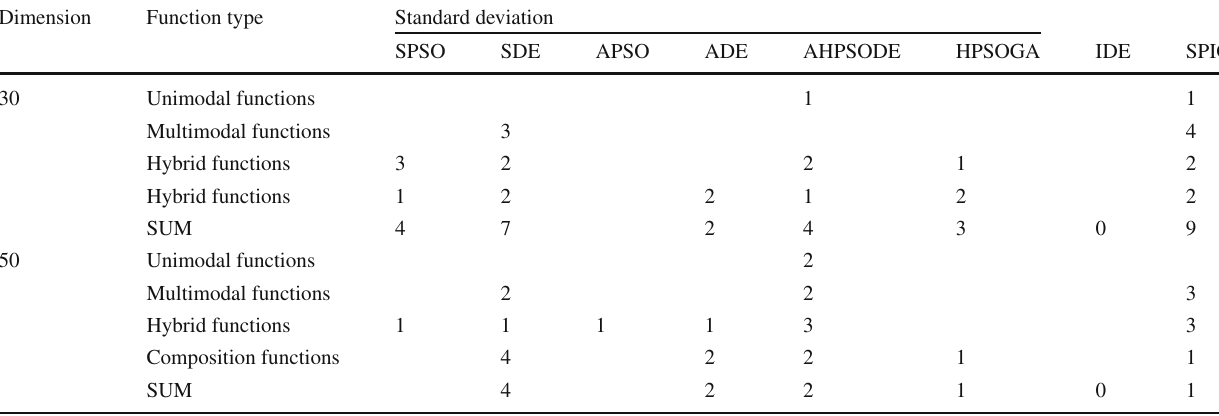
Table 5 Statistics of standard deviation for AHPSODE and compared algorithms on CEC 2017 Dimension Function